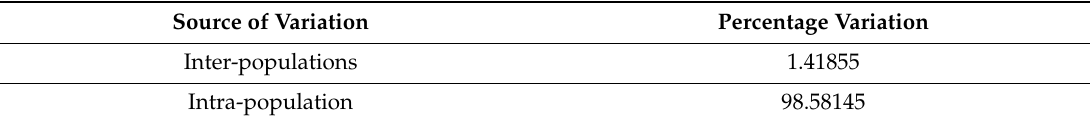
Table 6. Analysis of molecular variance.